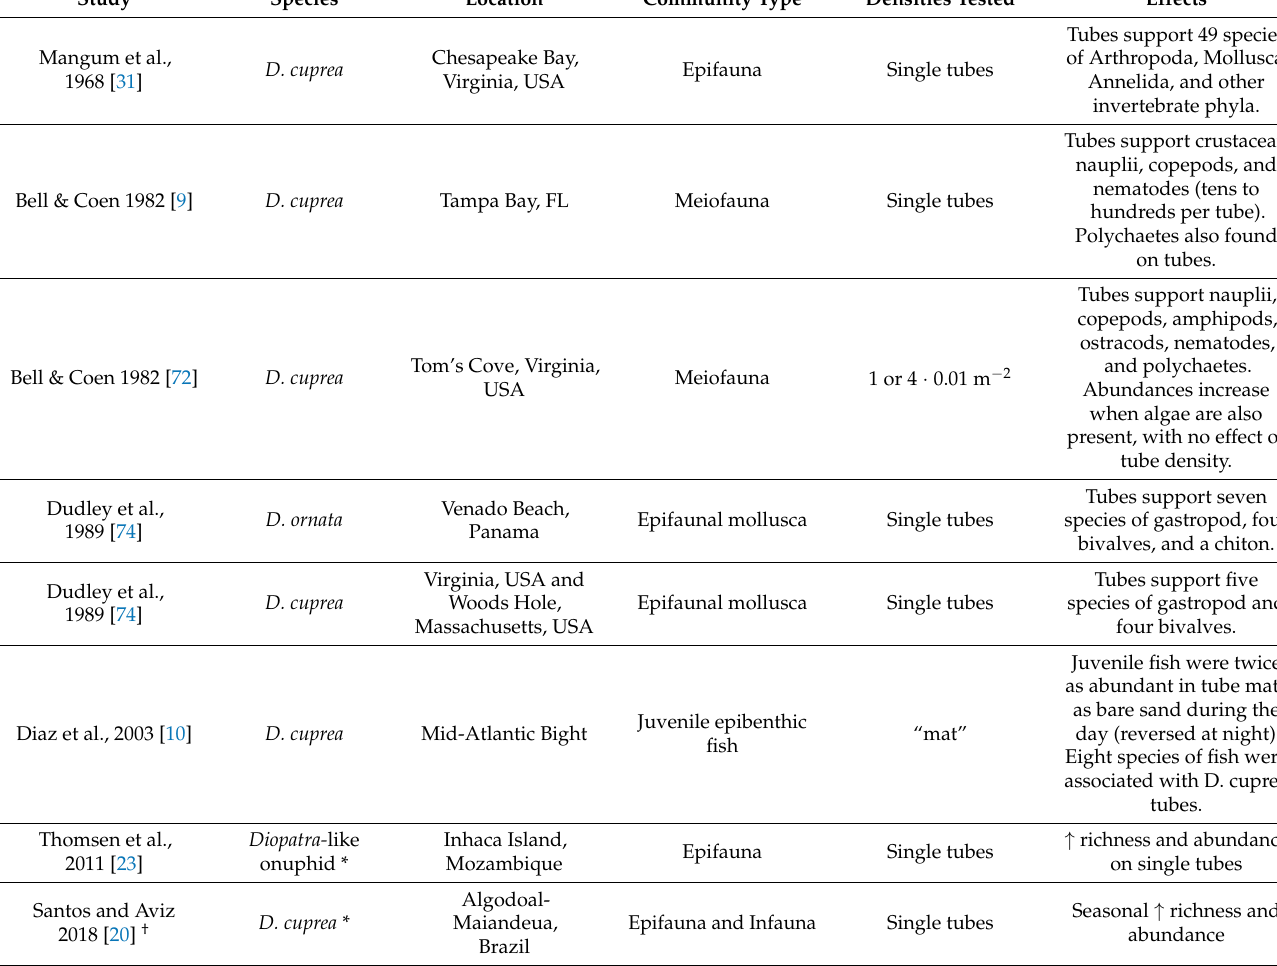
Table 3. Studies quantifying Diopatra facilitation of epibenthic